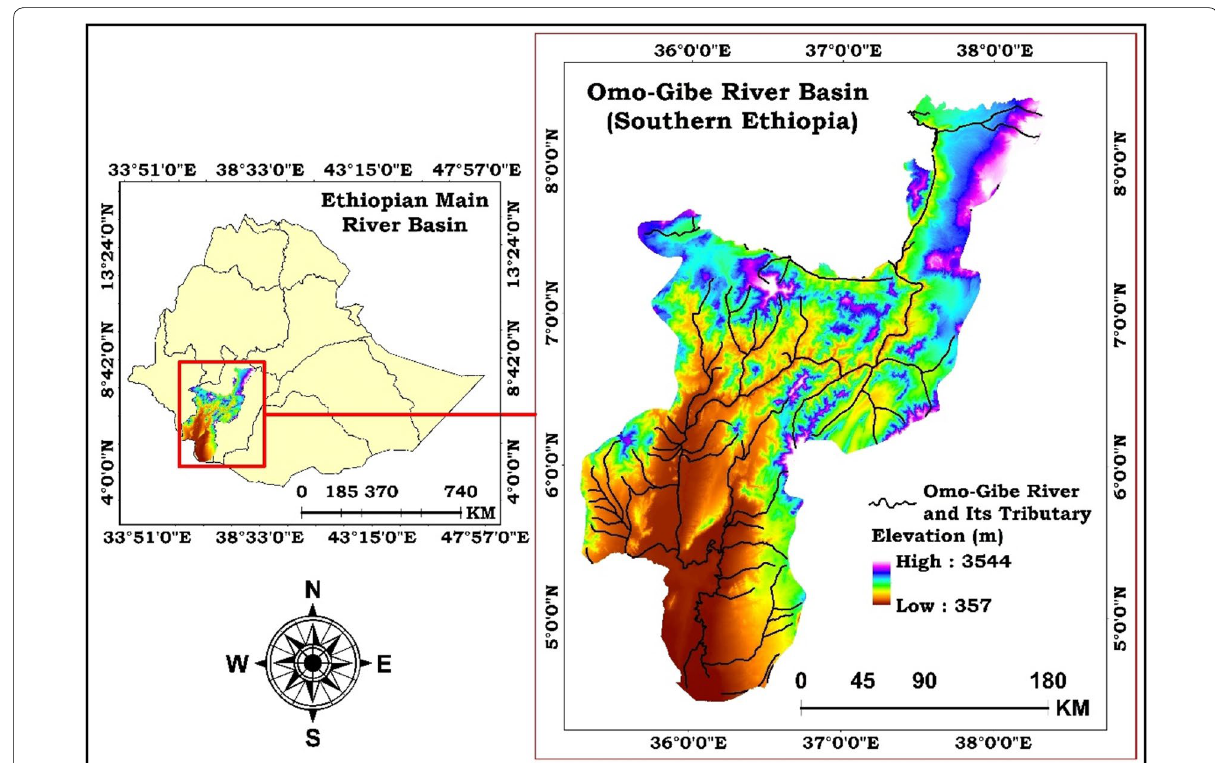
Fig. 1 Boundary of the study